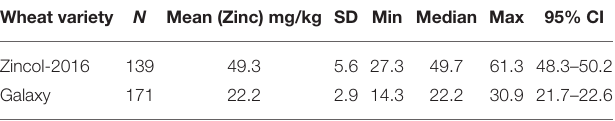
TABLE 3 | Zinc content of control (Galaxy) and biofortified (Zincol-2016) wheat grain.